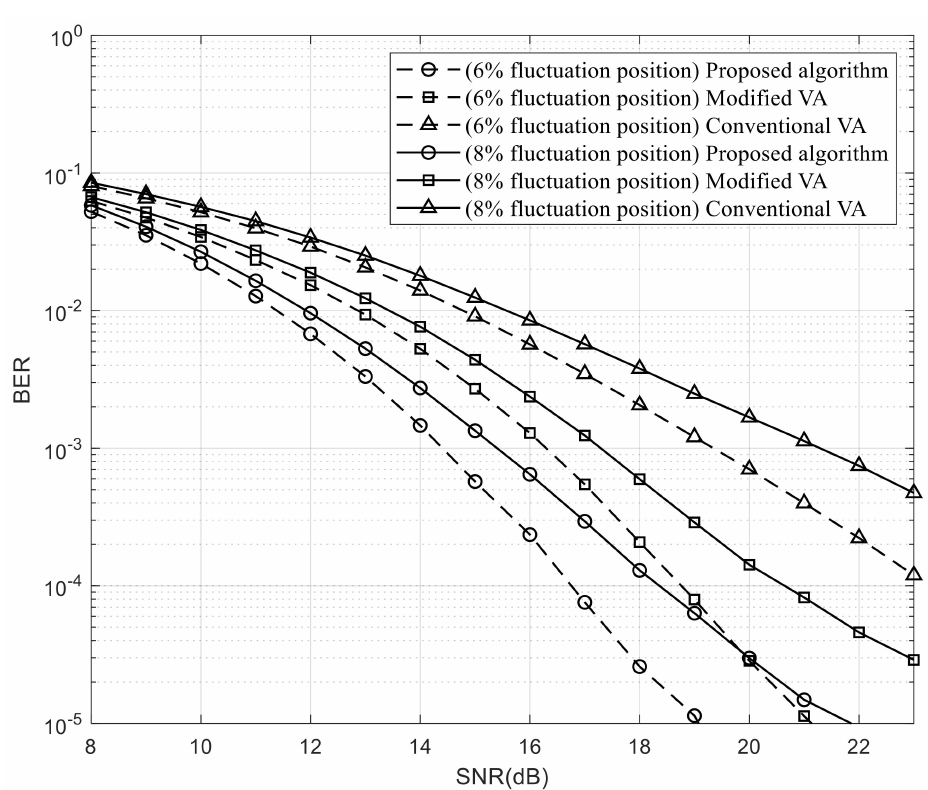
Figure 17. BER versus SNR for 6% and 8% position